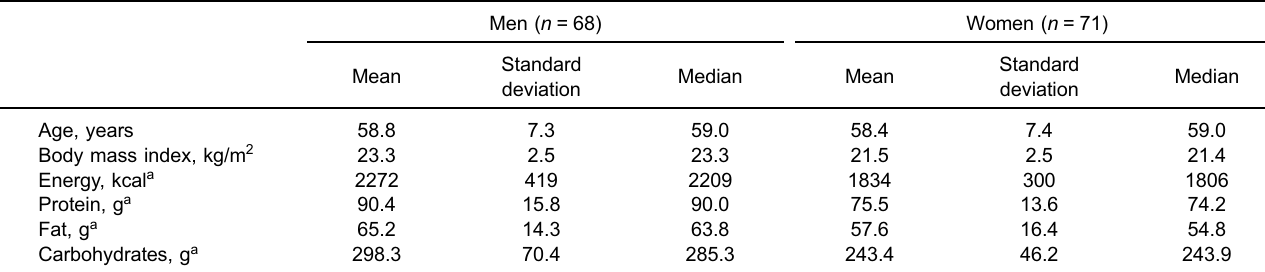
Table 1. Characteristics of study subjects Men ( n = 68) Women ( n = 71)